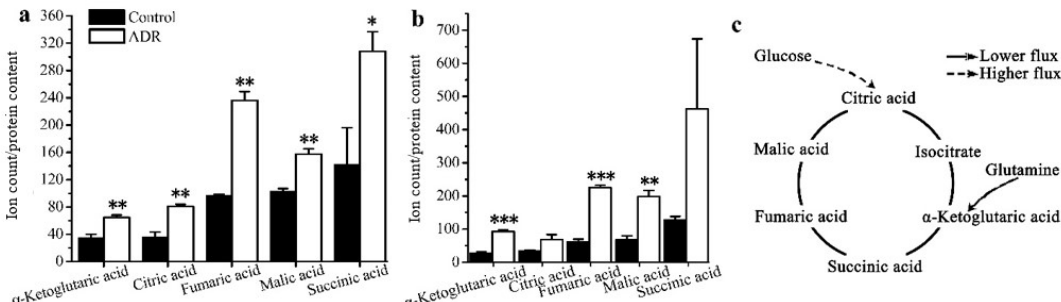
Figure 6. Levels of the (m + 0) isotopologue of TCA cycle intermediates for non-treated cells and ADR-treated cells: ( a ) MCF7; ( b ) MDA-MB-231. ( c ) A schematic characterization of TCA metabolites and how they might maintain cell senescence based on the isotopologue (m + 0) levels of TCA intermediates. * signifies p < 0.05; ** signifies p < 0.005 and *** signifies p < 0.0001.